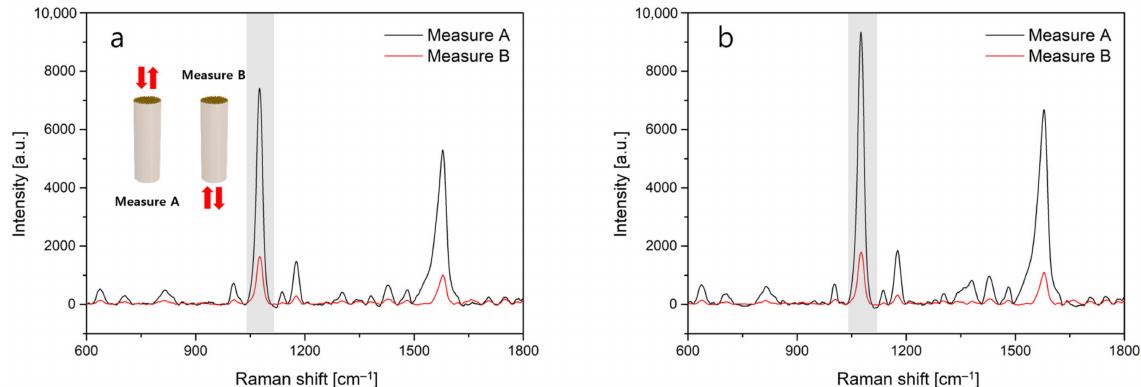
Figure 4. Measured SERS signals of 4-ABT molecules when laser light is incident to the fiber-top surface directly (Measure A) and when the light is coupled through the core/cladding structure (Measure B) for ( a ) a silk fiber and ( b ) a multi-mode fiber. The gray bar indicates the primary peak of 4-ABT molecules. The fiber length was fixed as 1 cm for both